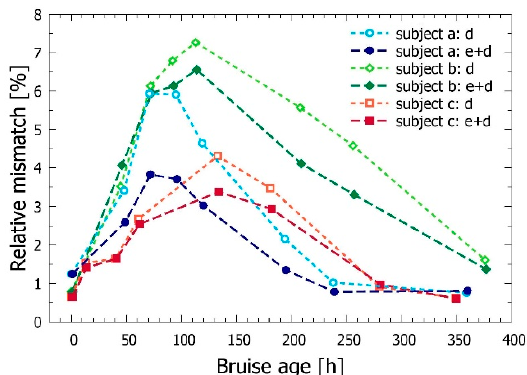
Figure 6. Relative mismatch ( δ , Equation (3)) between the measured and model-predicted diffuse reflectance values in the IMC analyses of the bruises in all three subjects at different times after the injury. Open symbols mark the results of the model with bilirubin only in the dermis, full symbols correspond to the bilirubin present in both epidermis and dermis.